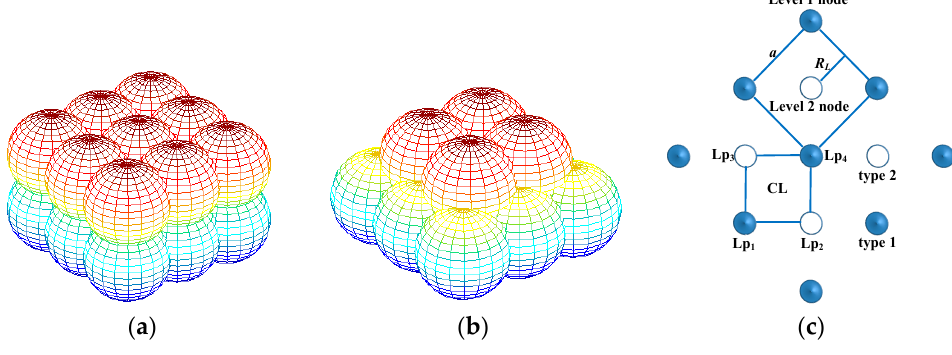
Figure 1. ( a ) NBCL, ( b ) CBCL and ( c ) Planar square lattice of NBCL.